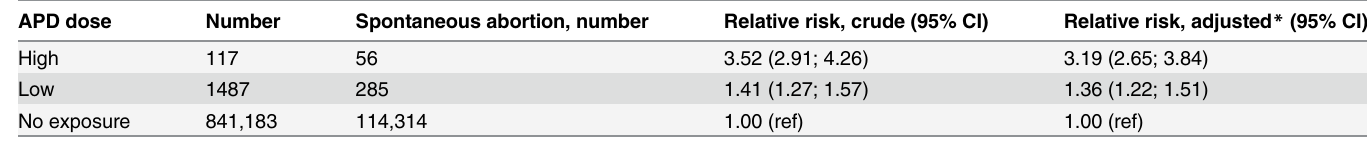
Table 4. Relative risk of SA following high and low dose of APD exposure in pregnancy (numbers refer to pregnancy outcomes). APD